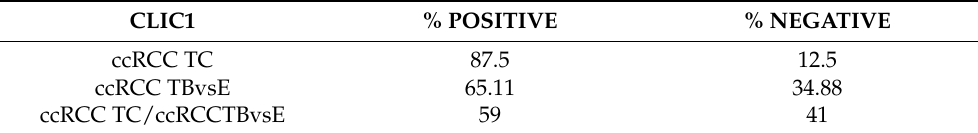
Table 1. Percentage of CLIC1-positive cases according to its expression in tumor cells (ccRCC-TC), tumor blood vessels endothelium (ccRCC-TBvsE), or its co-localization in both tumor cells and tumor blood vessel endothelium (ccRCC-TC/ ccRCC-TBvsE). CLIC1